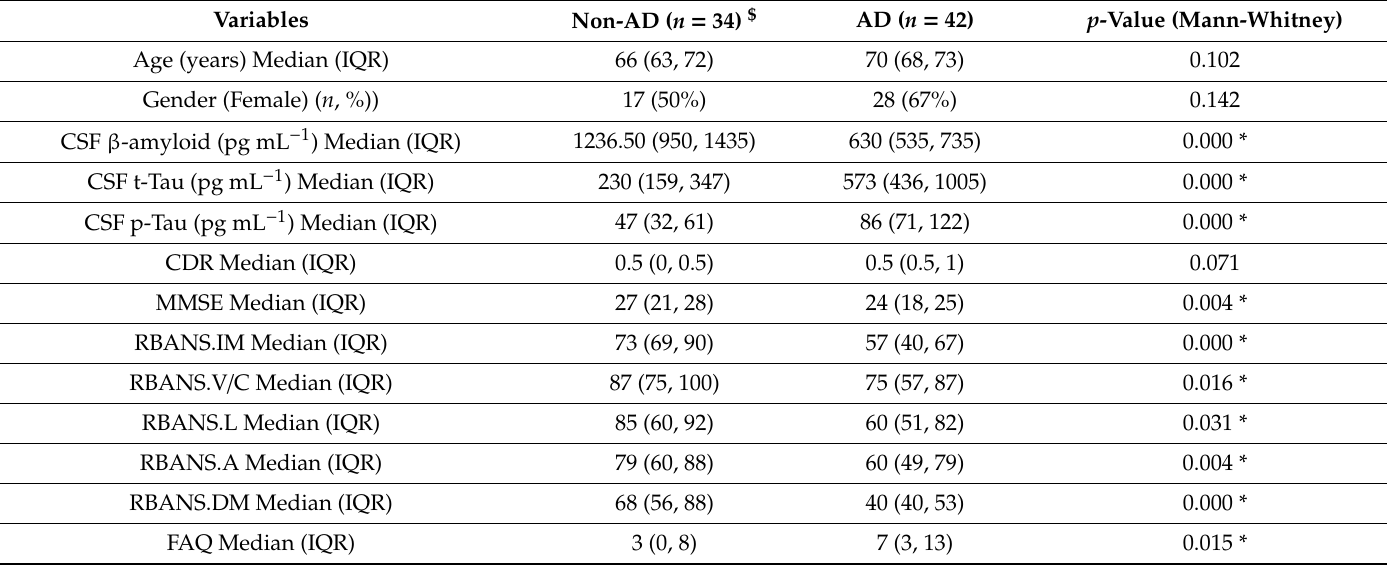
Table 1. Demographic and clinical variables of the study